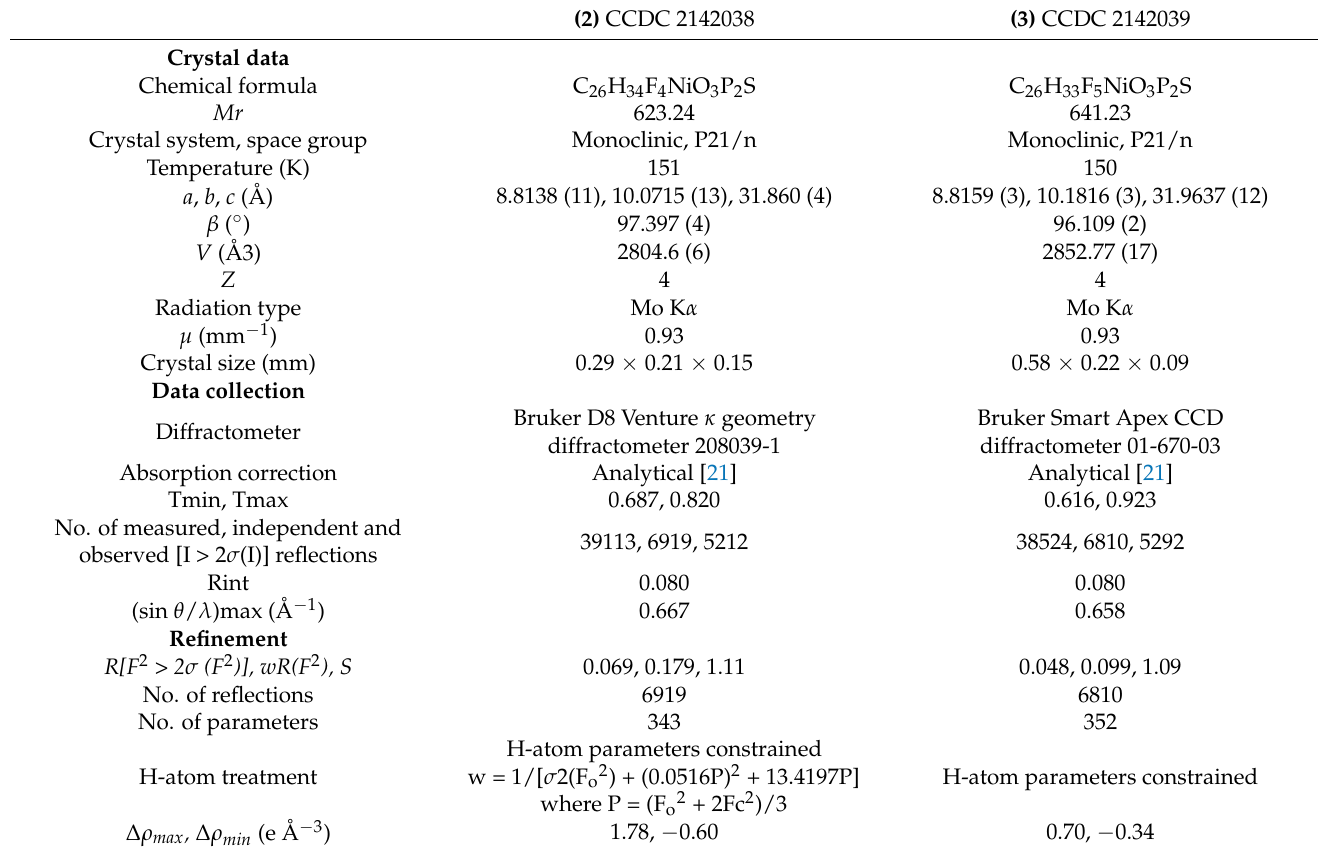
Table 1. Crystallographic experimental details for ( 2 ) and ( 3 ).